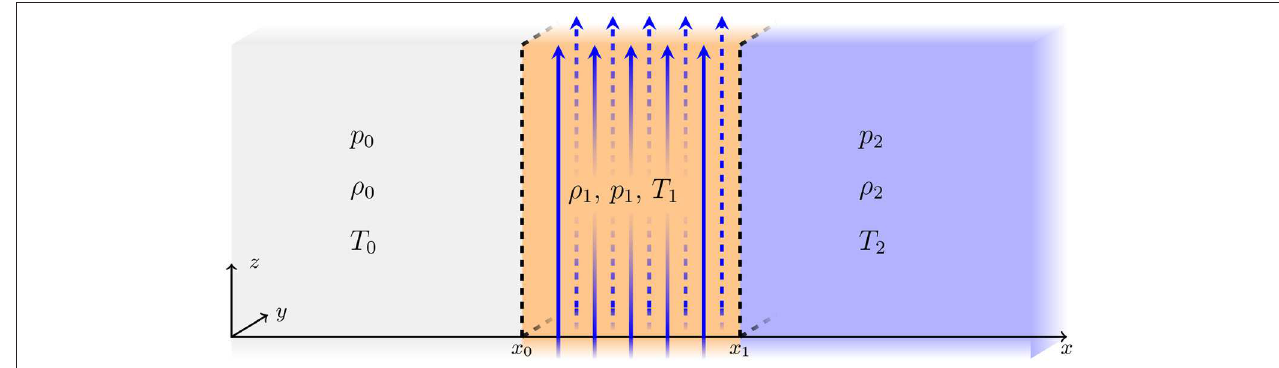
FIGURE 2 | The equilibrium configuration for a magnetic slab in an asymmetric non-magnetic environment.